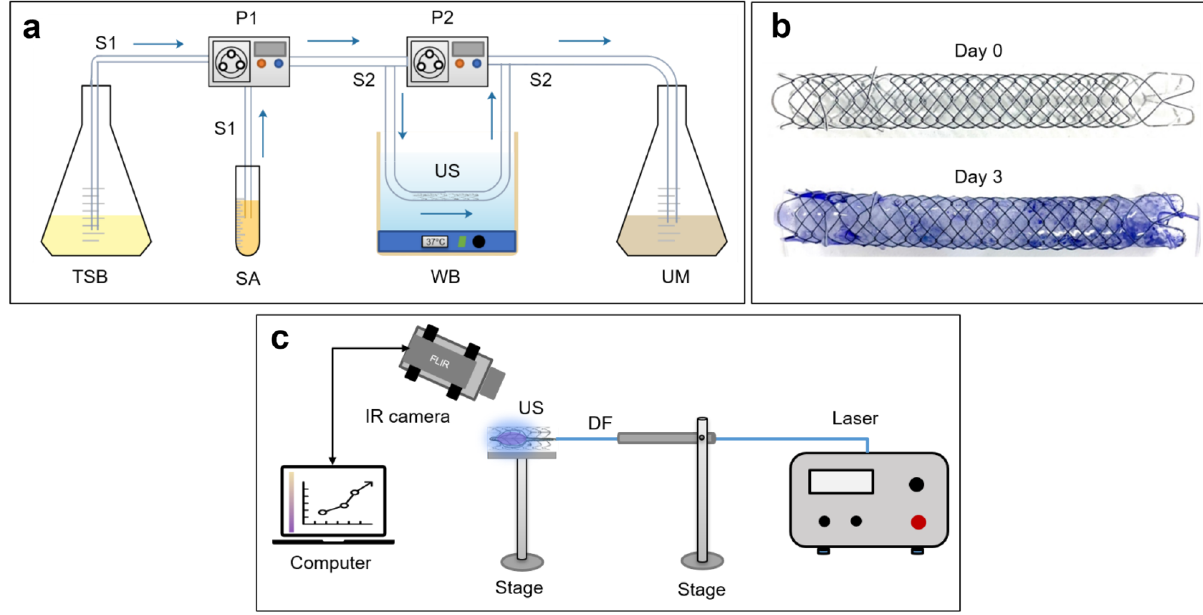
Figure 7. Schematic illustrations of bacteria preparation: ( a ) bacterial culturing in urethral stent under dynamic condition, ( b ) examples of urethral stent before (day 0) and after culturing, and ( c ) 405 nm laser treatment set up. (day 3; stained with crystal violet; TSB = tryptic soy broth media; SA = S. aureus suspension; WB = water bath; US = urethral stent; UM = used media;P1, P2 = pump, S1 = small silicone, S2 = large silicone, and DF = diffusing